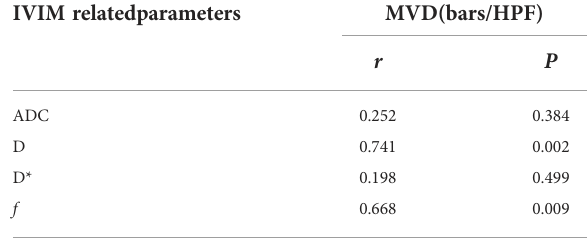
TABLE 2 The correlation between IVIM-related parameters and MVD in the experimental group after 14 days of TAE combined with apatinib treatment.